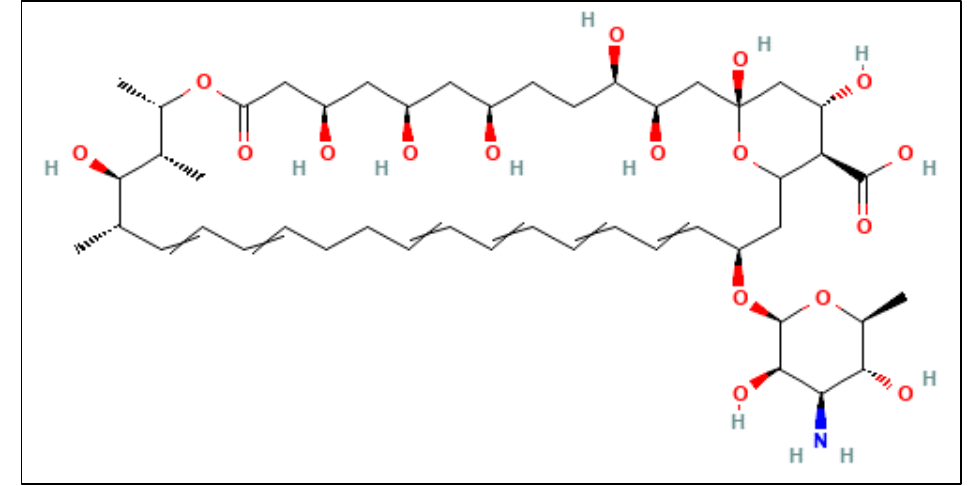
Figure 1. The structure of polyene antifungal (antimycotic) compound